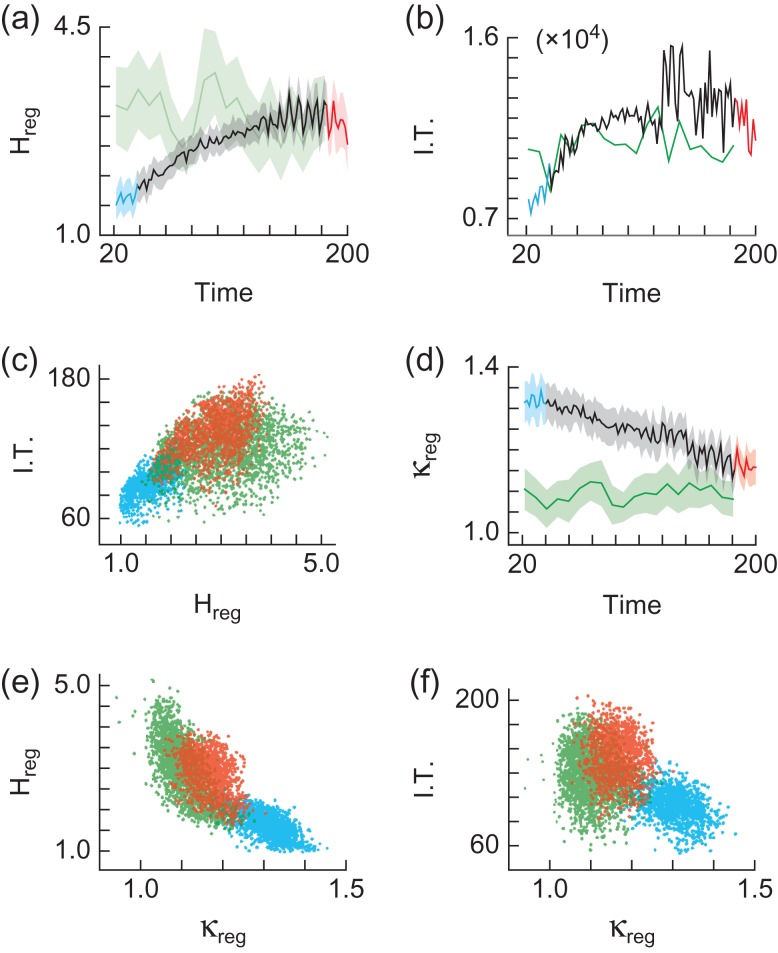
Regional information transmission with recovery from anesthesia. (a) Regional entropy Hreg (bits) vs. time (minutes) since drug delivery. Shaded region represents standard deviation. Color coding and mice as in Figure 2. (b) Time (minutes) since drug delivery vs. information transmission (bits). Color coding and mice as in Figure 2. (c) Information transmission (bits), as a function of regional entropy Hreg (bits). Color coding and mice as in Figure 2. (d) κreg as a function of time (minutes) since drug delivery. Shaded region represents standard deviation. Color coding and mice as in Figure 2. (e) Regional entropy Hreg (bits) as a function of κreg. Color coding and mice as in Figure 2. (f) Information transmission (bits), as a function of κreg. Color coding and mice as in Figure 2.